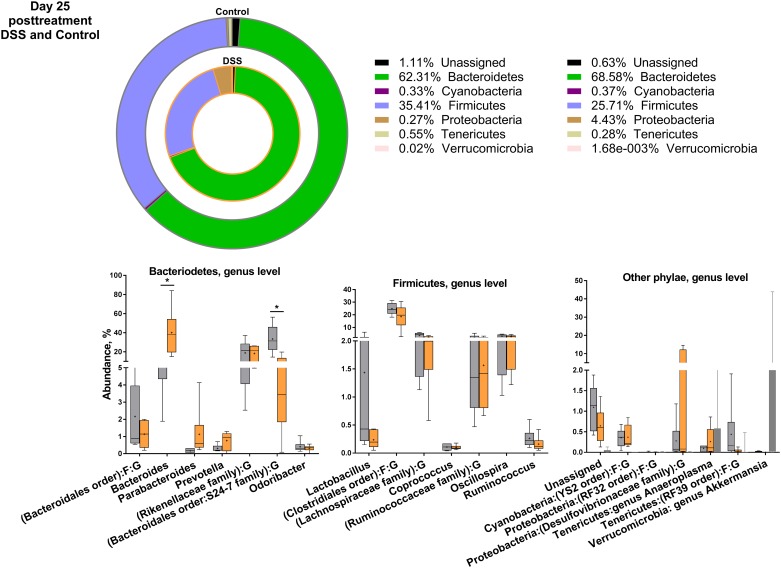
Distribution of the 20 most abundant phyla on day 25 post-treatment (Control and DSS).Overview of relative phylogenetic distribution and details of variation down to genus level of gut microbiota of untreated control mice compared to mice 25 days post-treatment with 1.5% dextran sulfate sodium (DSS). See S2 Table for analysis of variance.